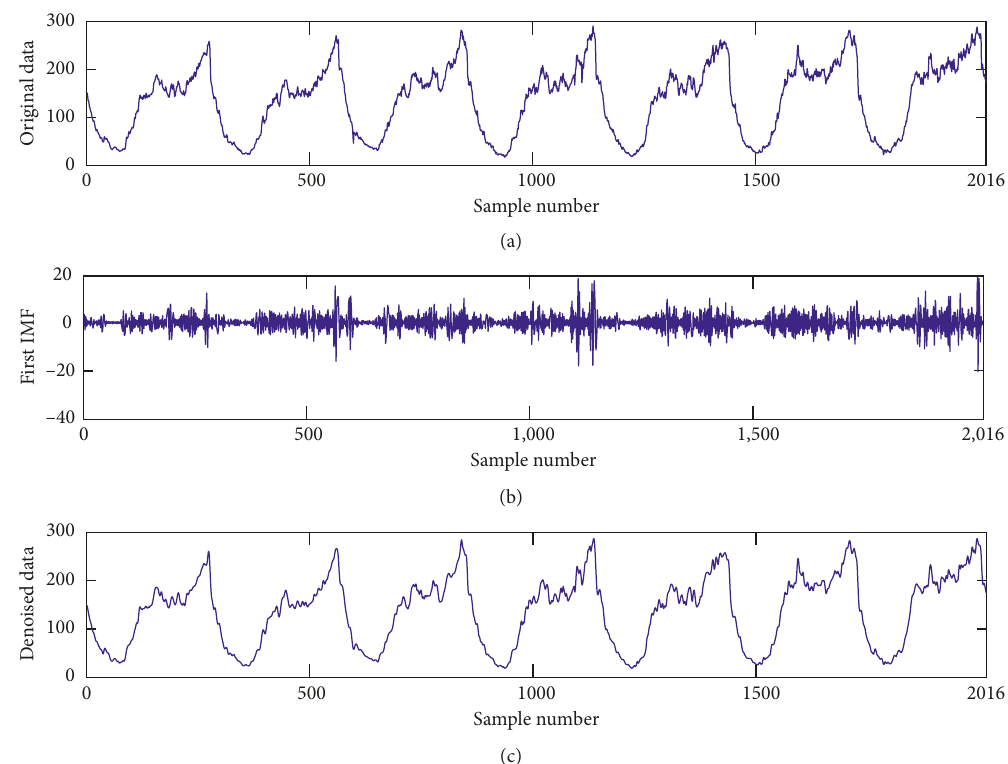
Figure 6: The noise eliminating process of outflow